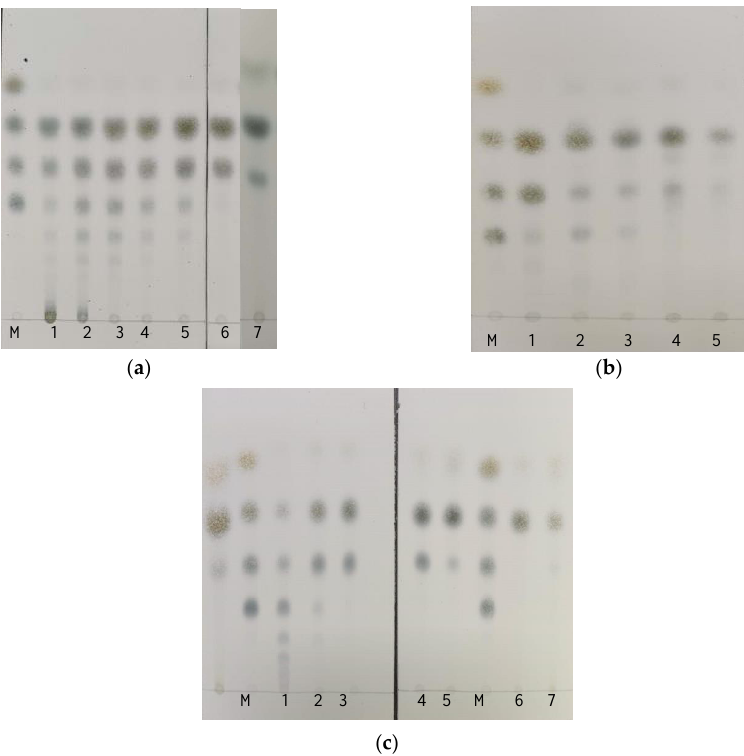
Figure 4. Thin layer chromatography (TLC) analysis of hydrolysates catalyzed by rAga-ms-R. ( a ) The hydrolysate of agarose. Lanes 1–6 represent hydrolysates of agarose incubated for 5, 15, 30, 60, 120 min and 1440 min, respectively. ( b ) The hydrolysate of agarose, Gracilaria sjoestedtii and Gelidium amansii for 120 min. Lanes 1–5 represent hydrolysates of agarose, Gracilaria sjoestedtii (sterilized for 15 min), Gracilaria sjoestedtii (raw), Gelidium amansii (sterilized for 15 min) and Gelidium amansii (raw). ( c ) The hydrolysate of NA8, NA6, NA4. Lanes 1–5: hydrolysate of NA8 for 5, 30, 60, 120 and 1440 min, respectively. Lane 6: hydrolysate of NA4; lane 7: hydrolysate of NA6.